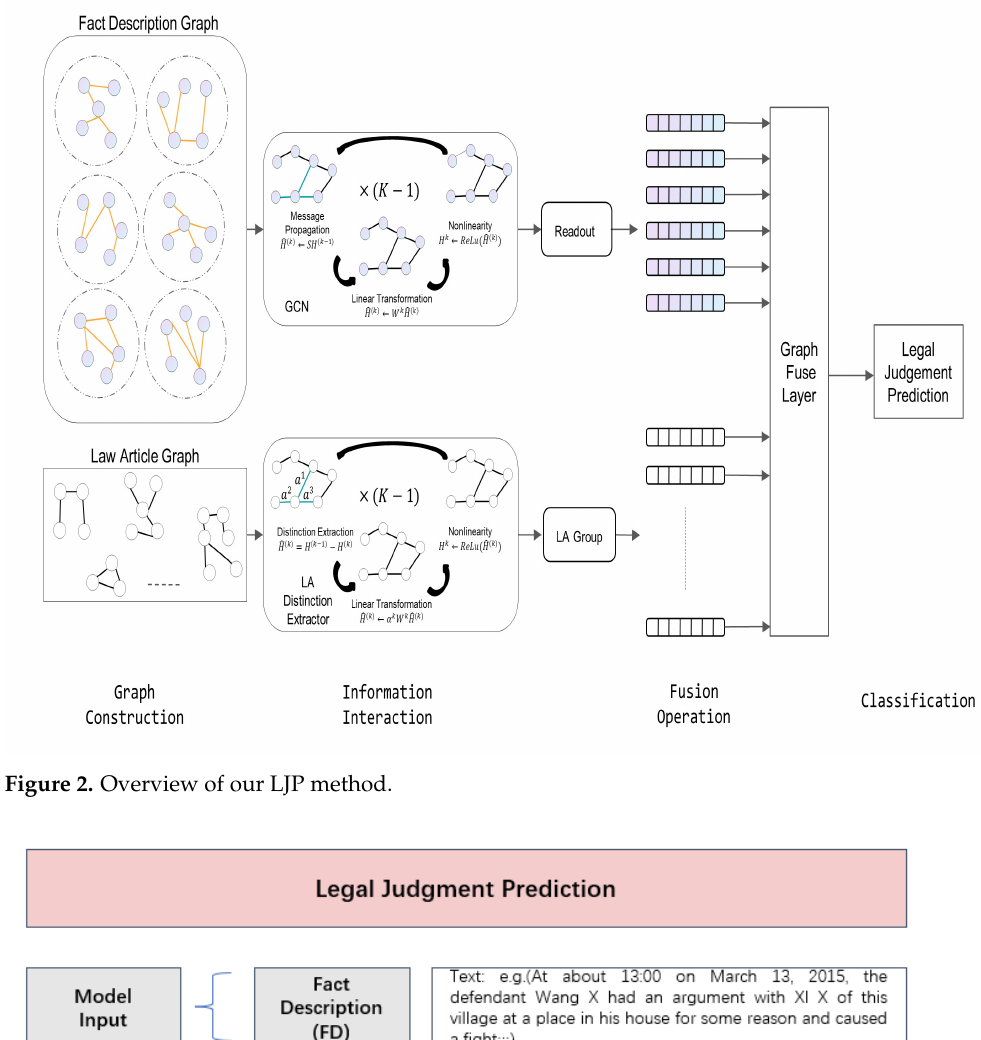
Figure 2. Overview of our LJP method.